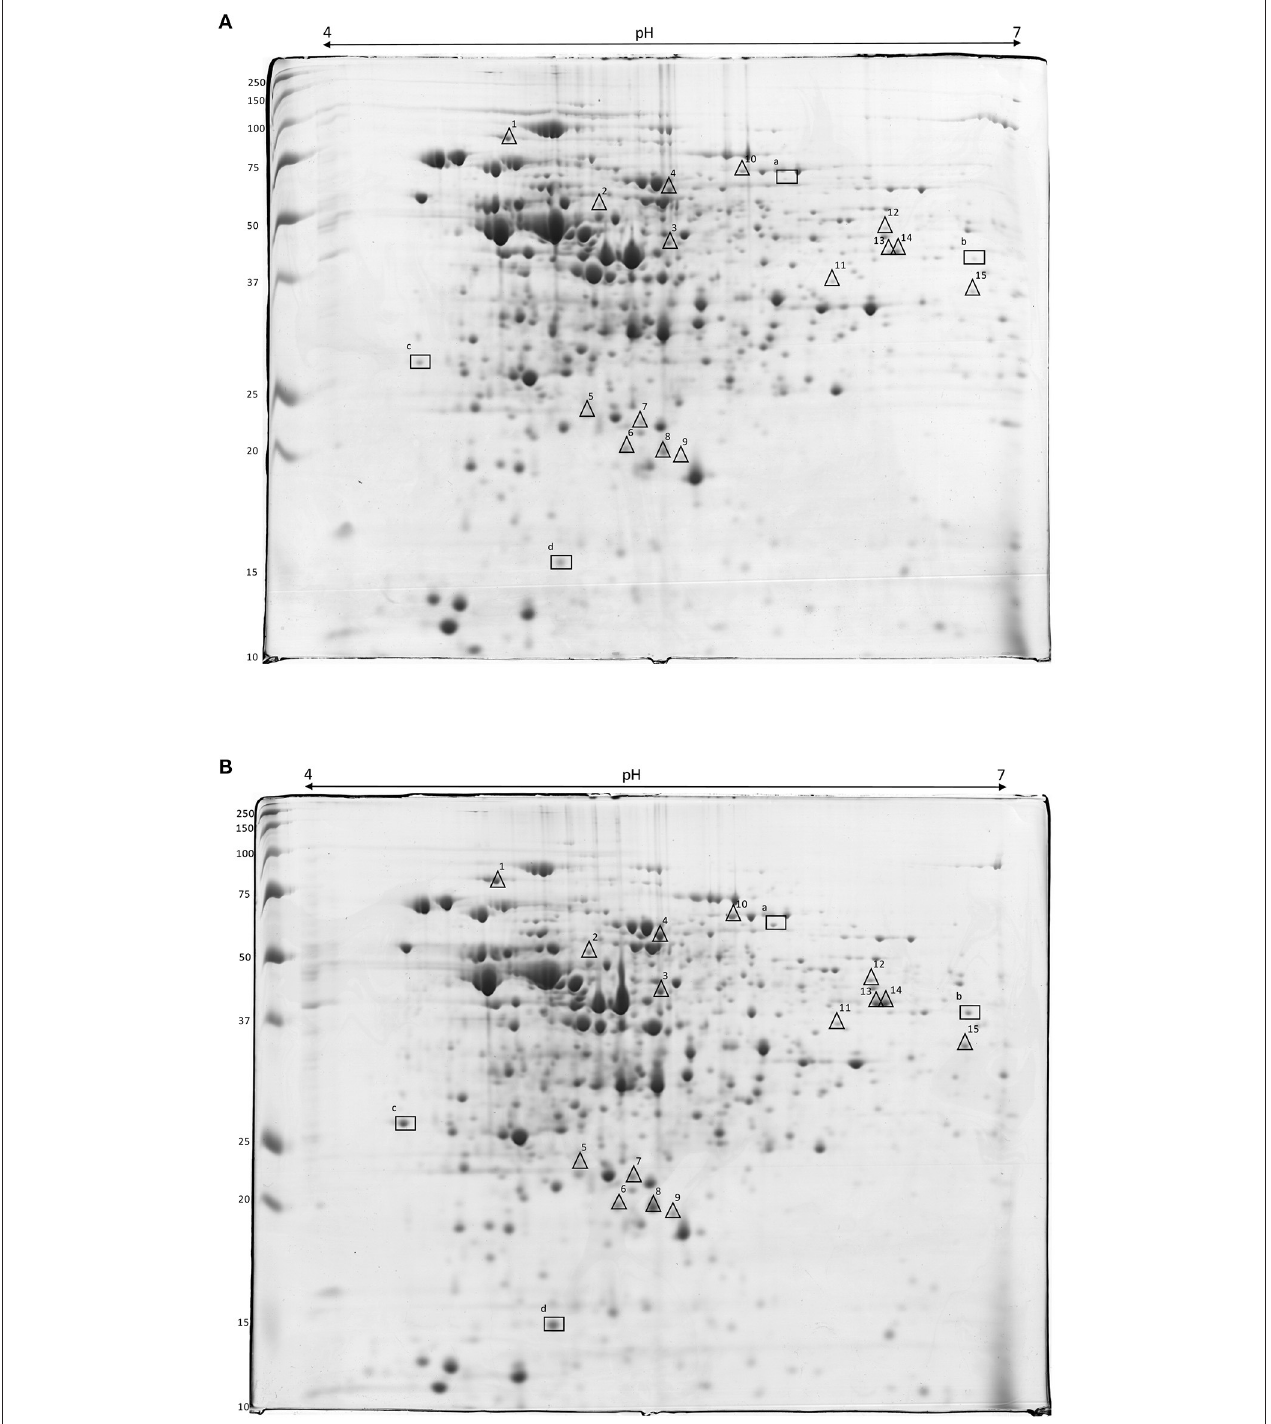
FIGURE 3 | 2-DE gels of crude extract proteins of L. innocua ATCC 33090 cultivated in conventional (A) and in acid stress (B) conditions. Symbols show the spot proteins strongly ( 1 ) or very strongly ( (cid:3) ) up-regulated in acid stress condition.